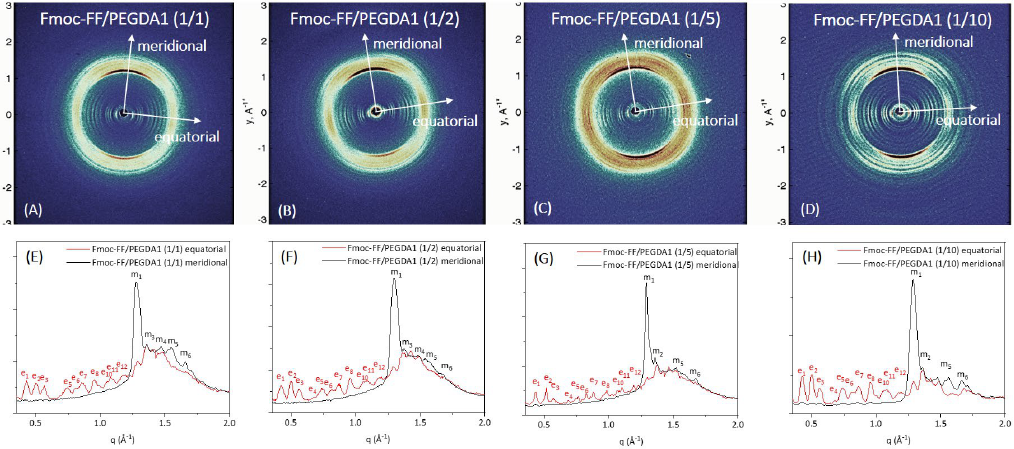
Figure 7. WAXS characterization of the mixed hydrogels Fmoc-FF/PEGDA1 at different concentra- tions: 2D WAXS data (on the top row right) and 1D WAXS meridional (black line)/equatorial (red line) profiles (on the bottom row).